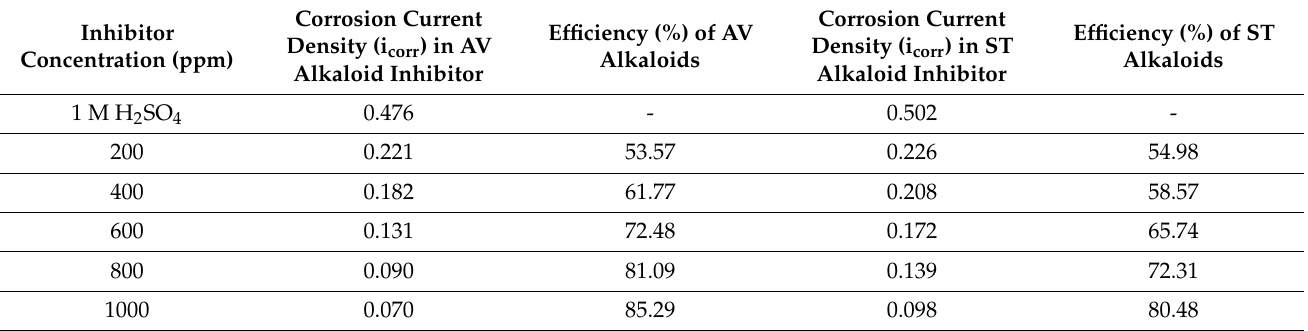
Table 1. Inhibition efficiency of AV alkaloids and ST alkaloids for as-immersed MS sample by polarization method.